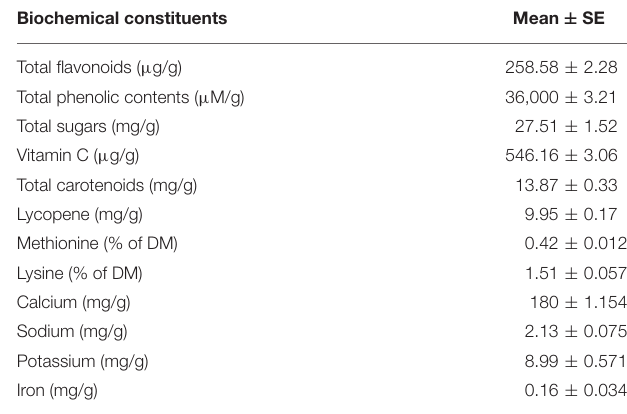
TABLE 2 | Chemical composition of basal diet and MOLP (Dry matter basis). TABLE 3 | Biochemical/nutritional constituents of Moringa oleifera leaf powder. Biochemical